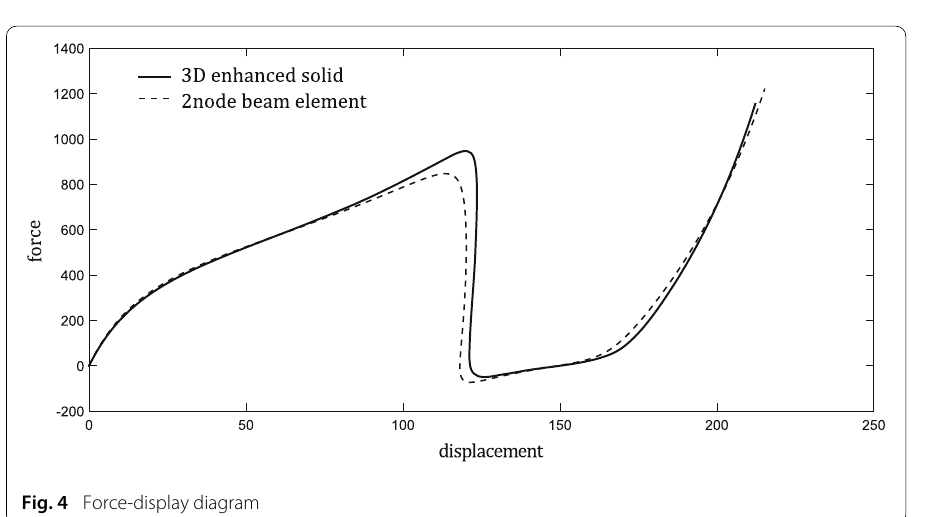
and EI = 159 Nm 2 . The finite element model employs 6 two-node beam elements. The lower end of the beam is fixed, while a square plate is attached at the other end in the center c as shown in Fig. 5. The plate is composed of four proposed solid elements with E = 5000 N/m 2 and ν = 0. The beam is subjected to a torque through the external forces applied to the four corners of the plate. The direction of forces is given in Fig. 5. The total moment at point c , provided by the forces F i = 1 , 4 is calculated as M τ = 4 a × F . The angle of twist can be found by using the following formula M τ l θ = GI where G is the shear modulus. For the chosen characteristics ( F i = 1 , 4 = 3 . 9 N), the value of the angle of twist is Π/ 4. The computation is performed in 10 increments of Δ t = 0 . 1 s. The numerical solution corresponds perfectly to the analytical solution: the rotation θ 6 at node c is equal to 0 . 78541 ≈ Π/